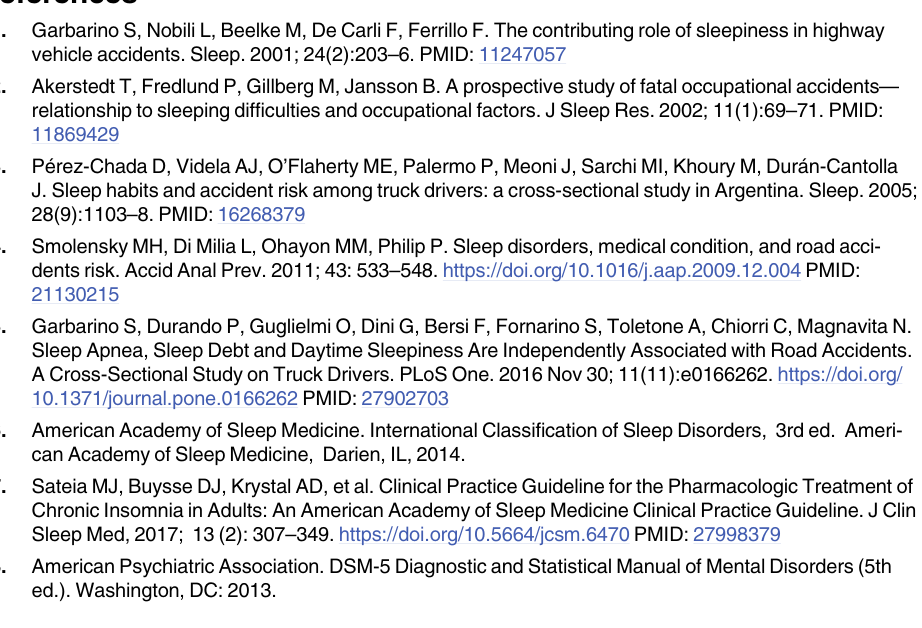
S2 Table. Multivariate association between sleep variables and NMAs.